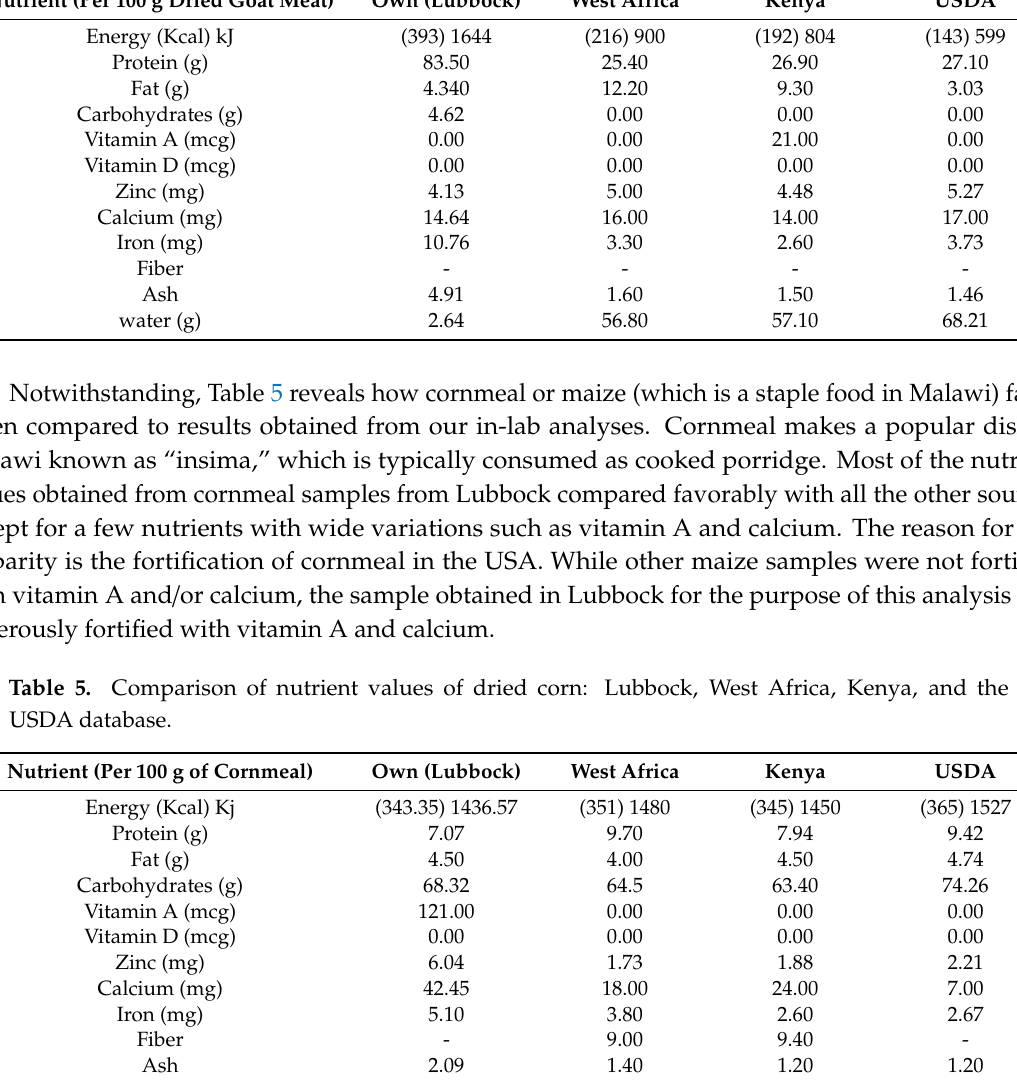
Nutrient (Per 100 g Dried Goat Meat)